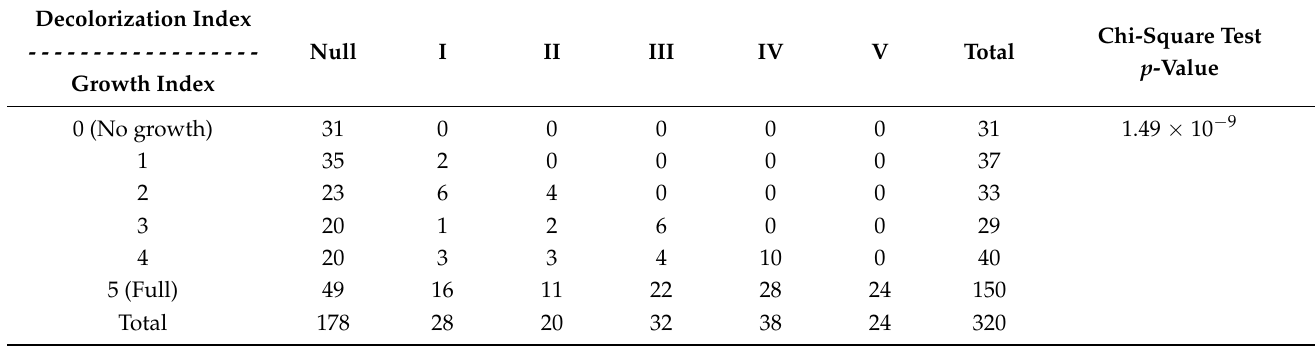
Table 1. Number of fungal isolates, out of 320, assigned a given growth rate or DR5B dye- decolorization level rating after ten days of incubation on PDA or PDA+DR5B, respectively. The numeric value in each cell presents the number of isolates that were assigned with the corresponding decolorization and growth index.